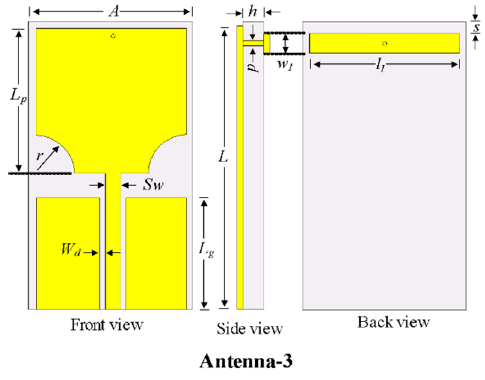
Figure 5. Design procedure to achieve conventional notched UWB patch antenna.